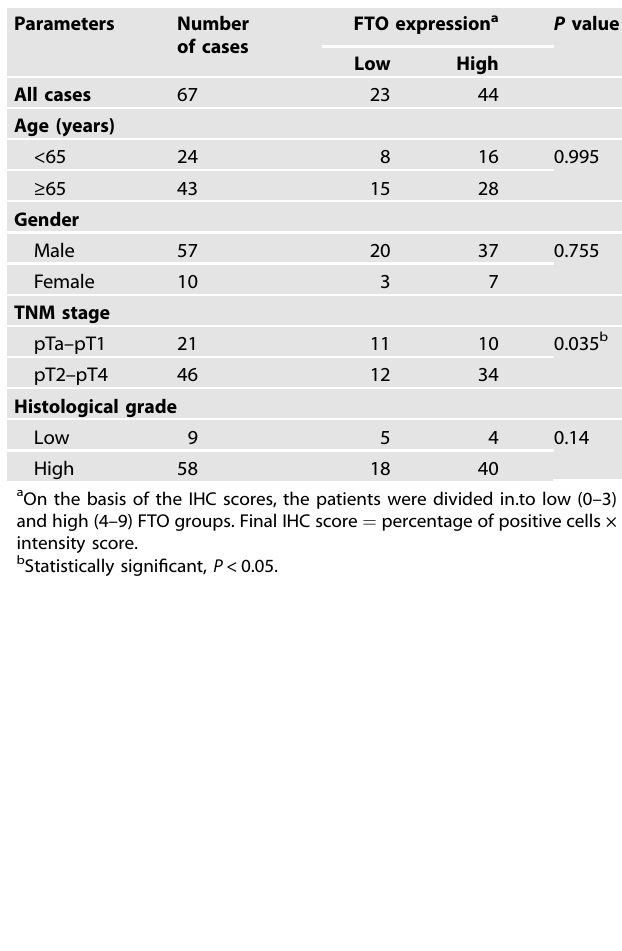
Table 1. Correlation between FTO expression and clinicopathological characteristics of 67 bladder cancer